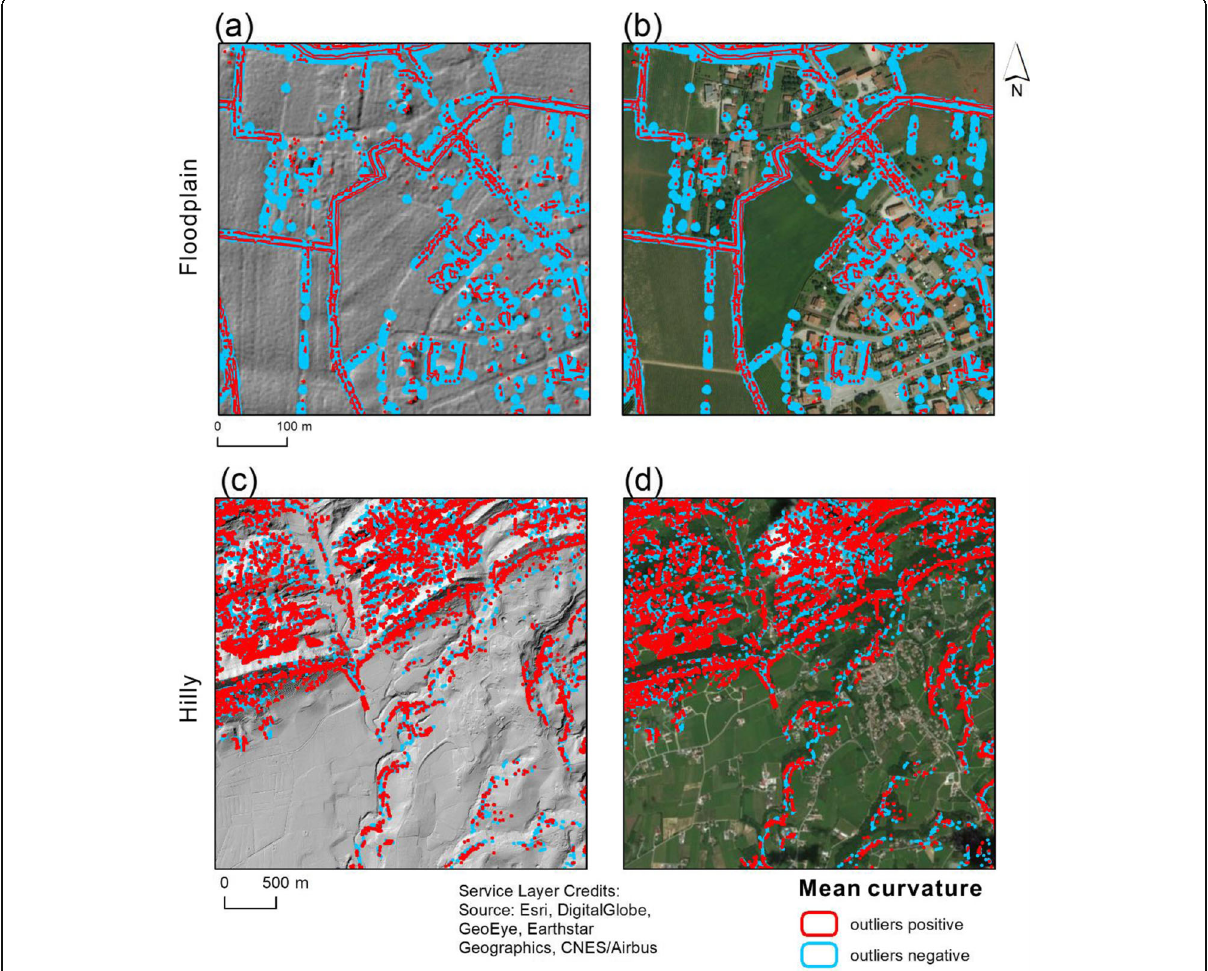
Fig. 12 The positive and negative outliers identified from mean curvature in the floodplain ( a ) and hilly area ( c ), the left side are the DTMs, and the right side ( b ) and ( d ) are the satellite images. The location of the study areas is marked in black rectangle in Fig.